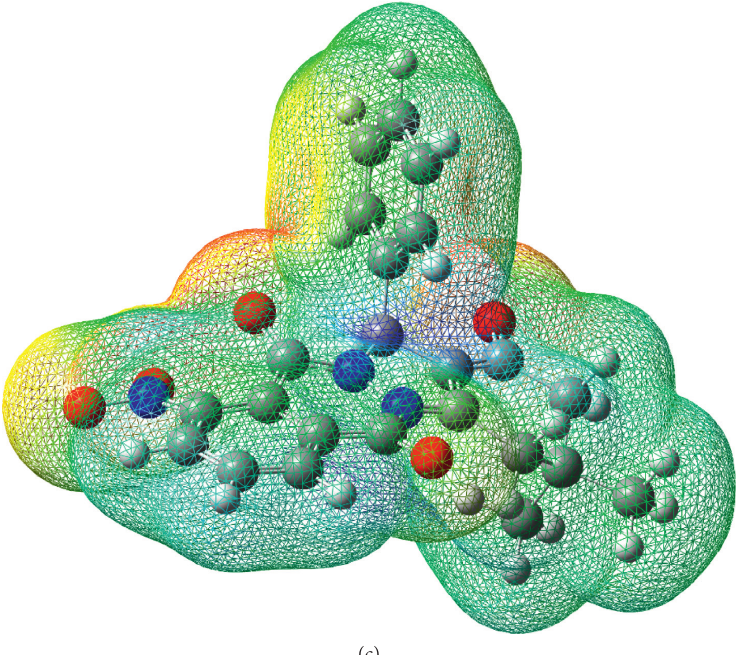
Figure 2: Molecular electrostatic potential (MEP) maps of the title compounds calculated using the B3LYP/6-311+G(d)